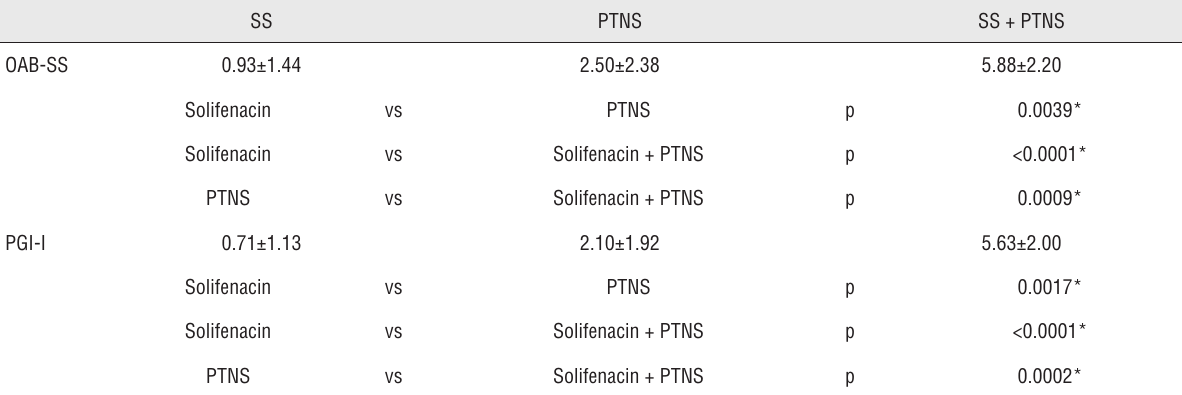
Table 3 - Persistence of improvements in months, assessed with Overactive Bladder symptoms score (OAB-ss) and Patient Global Impression of Improvement (PGI-I) questionnaire (follow-up of 10